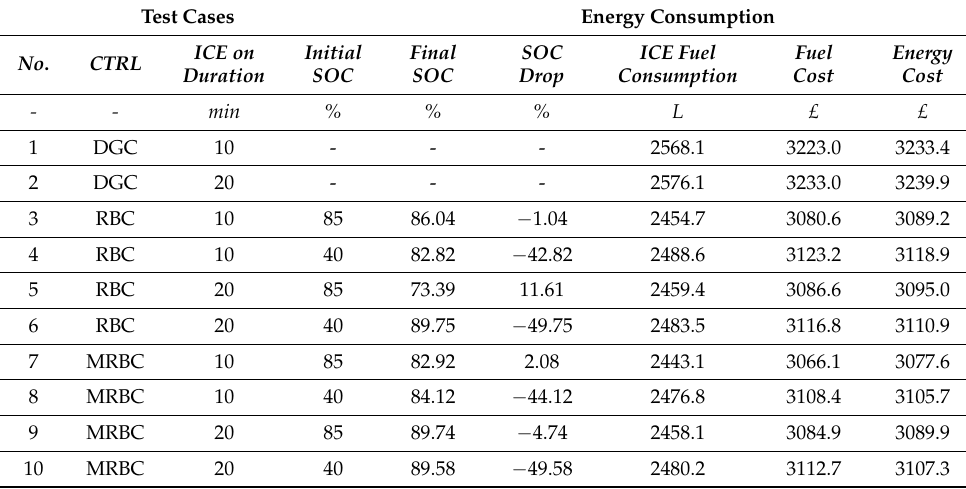
Table 7. Comparison of energy consumption under MIL and HIL simulation